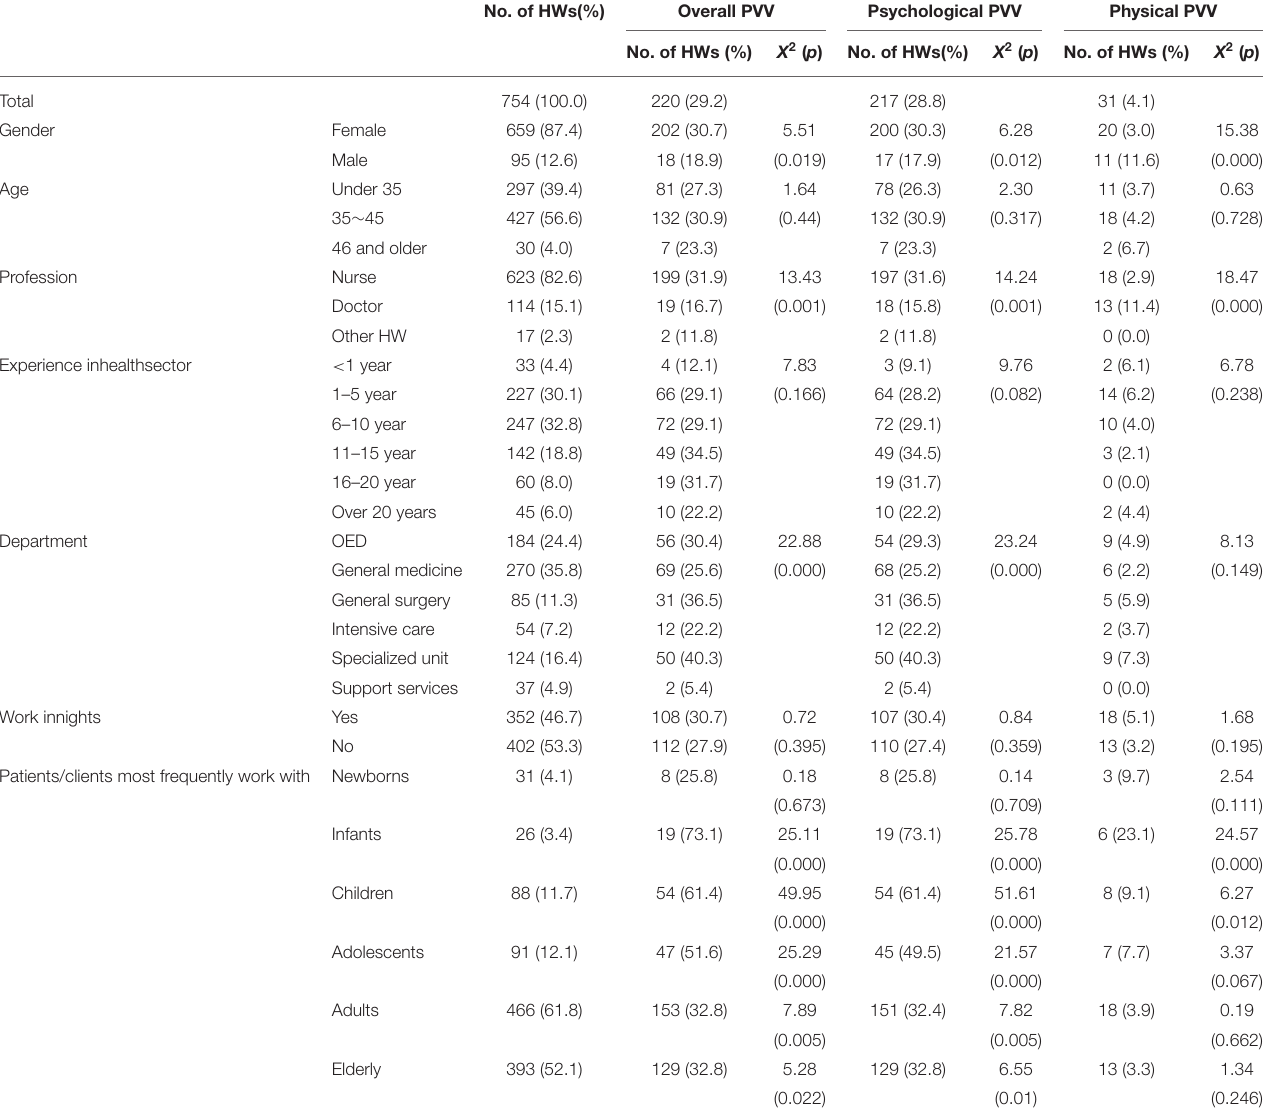
TABLE 2 | Characteristics and frequency distributions for PVV among 754